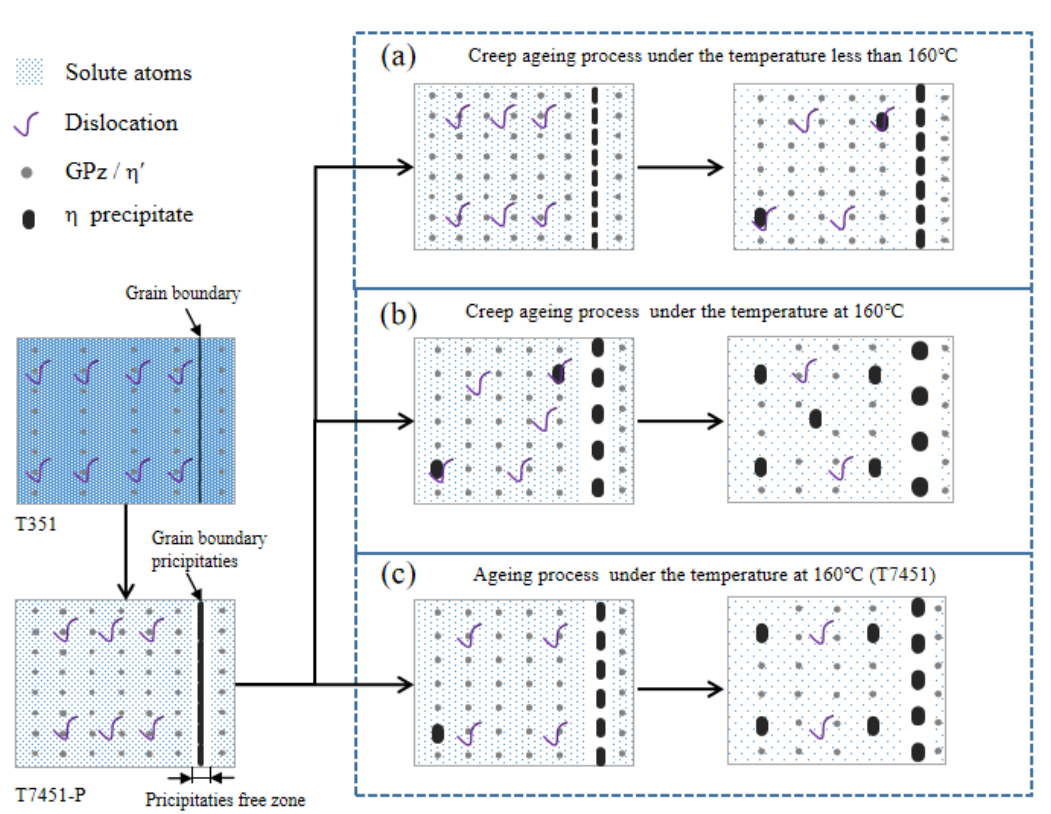
Figure 14. Schematic illustration of microstructure evolution during creep aging tests at: ( a ) low-temperature high stress; ( b ) high temperature with high stress; ( c ) high temperature with un-stressed.